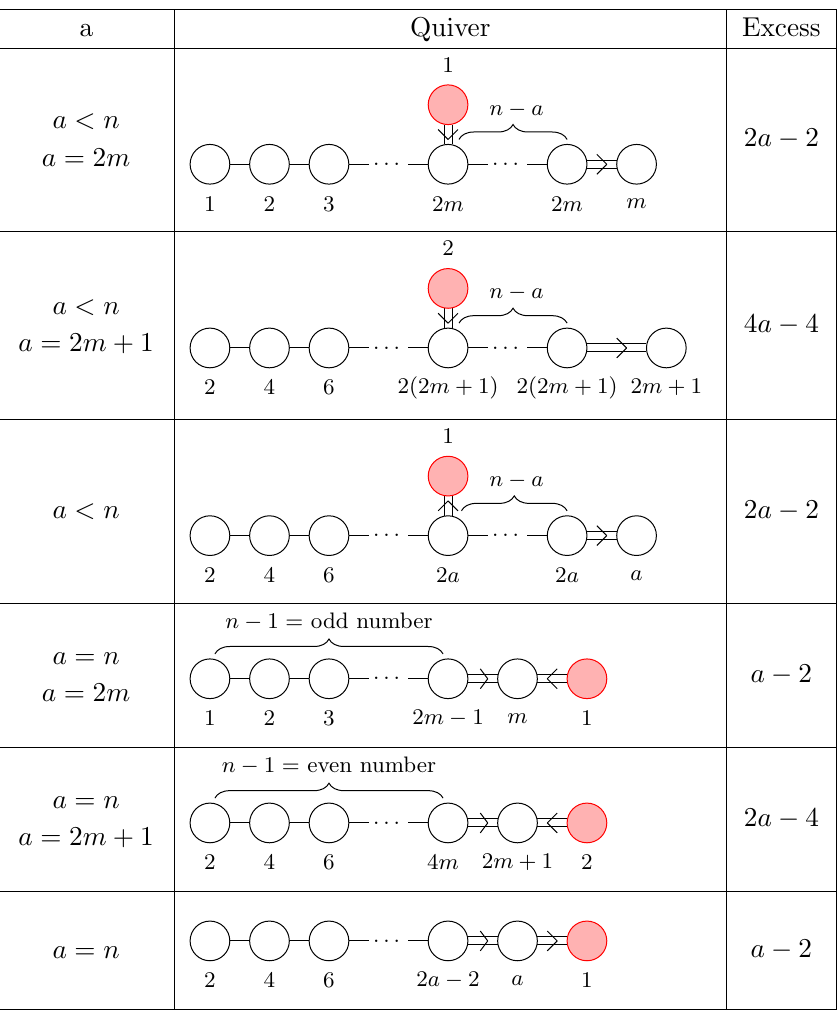
Table 28 . Exotic minimally unbalanced quivers with G = SO(2 n + 1) and an extra double laced